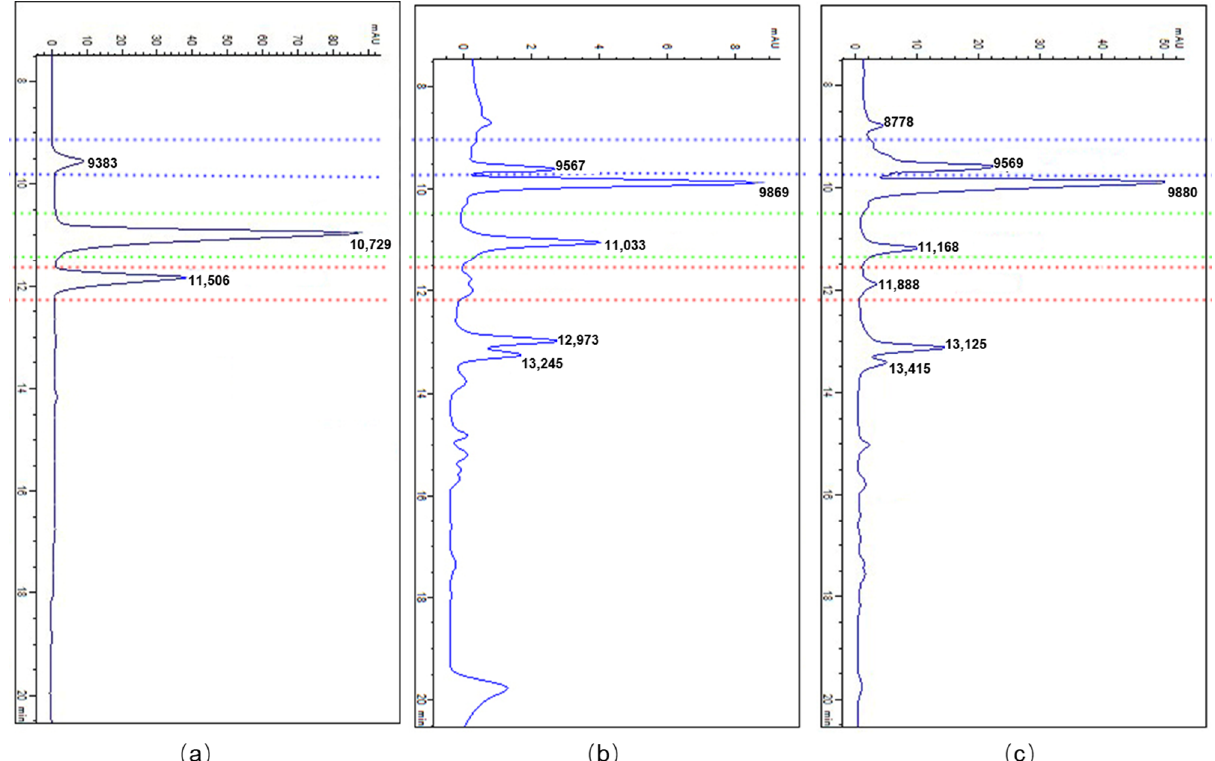
Figure 6. Retention time and absorption spectrum of BAPs and their external standards, as determined by high-performance liquid chromatography (HPLC). ( a ) HPLC chromatogram of the external standard of chelidonine, berberine, and sanguinarine, ( b ) HPLC chromatogram of the extract of cultured cells as a control sample, and ( c ) HPLC chromatogram of the cell extraction after 72 h of MJ elicitation. Retention time and peak shape of chelidonine, berberine, and sanguinarine are represented by blue, green, and red dotted lines, respectively.